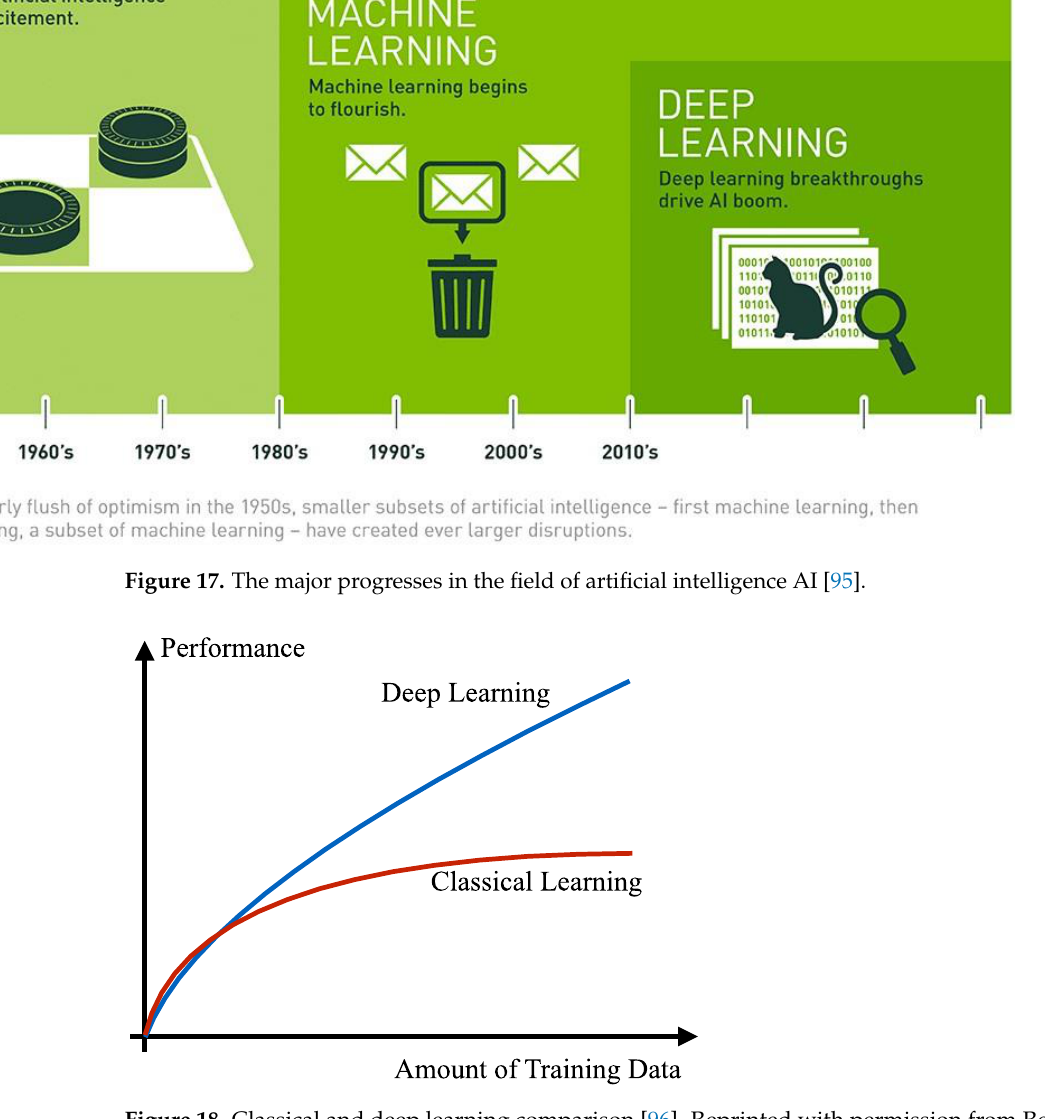
Figure 18. Classical and deep learning comparison [96]. Reprinted with permission from ref. [96]. 2019 Institute of Electrical and Electronics Engineers.